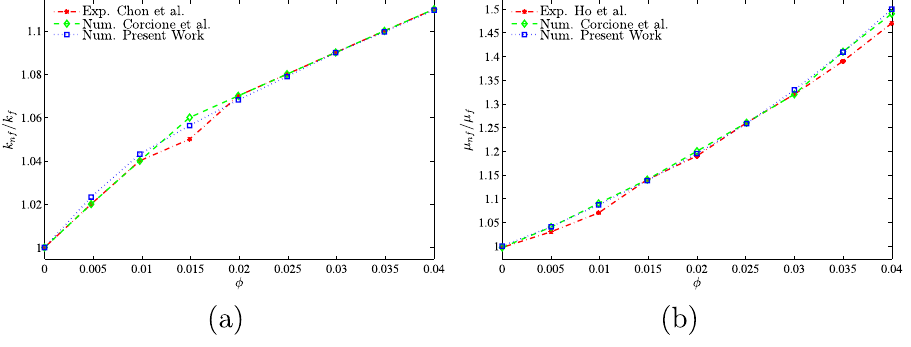
Figure 6. Comparison of ( a ) thermal conductivity ratio with Chon et al . 49 and Corcione et al . 46 and ( b ) dynamic viscosity ratio with Ho et al . 44 and Corcione et al . 46 .